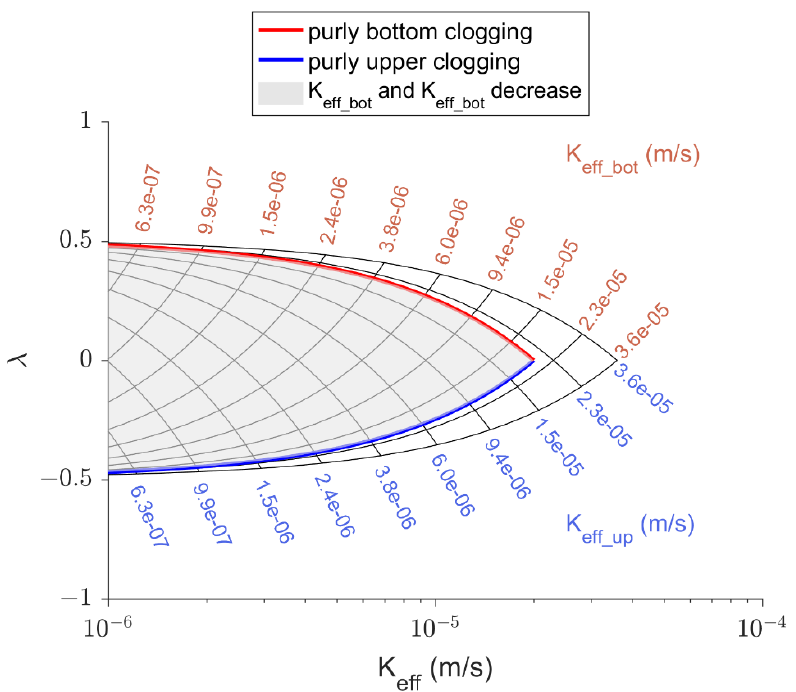
Figure 2. An example of the λ - K ef f diagram. The red solid line indicates the development of pure bottom clogging. The blue solid line indicates the evolution of pure upper clogging. The region that is encircled by red and blue solid lines denotes mixed clogging (i.e., upper clogging and bottom clogging occurring simultaneously). K ef f _ up ( t = 0 ) = 2.00 × 10 − 5 (m/s). K ef f _ bot ( t = 0 ) = 5.49 × 10 − 5 (m/s). L up = 0.93 (m). L bot = 0.9025 (m).